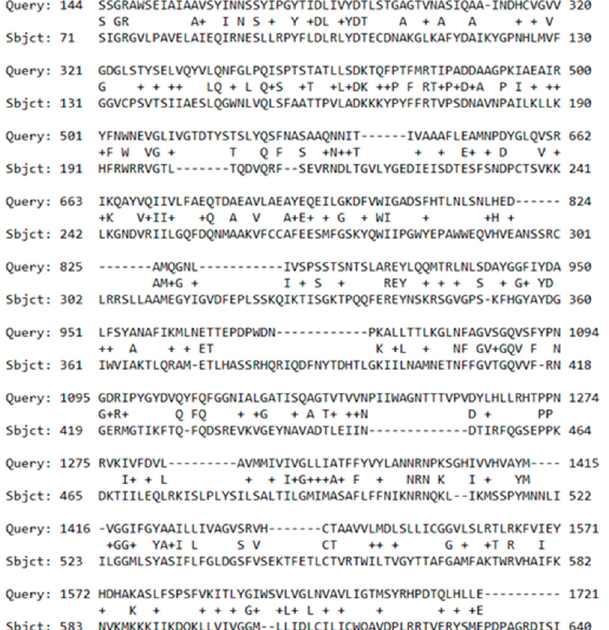
Figure 3. Transcript alignment to GABA receptor. Alignment section of the first hit between Physarum transcript 03383 and the protein sequence O88871 coding for the GABA type B receptor subunit 2 in Rattus